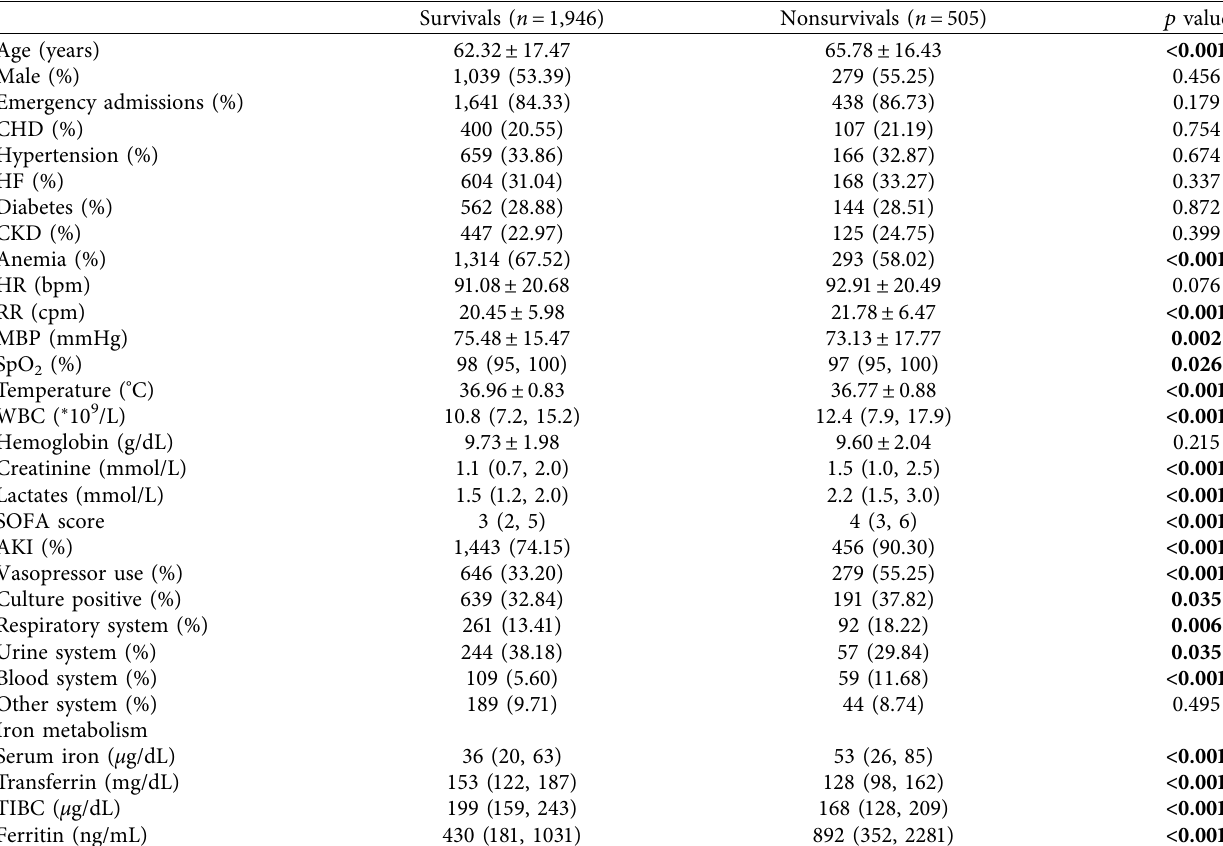
Table 1: Comparisons of information between survivors and